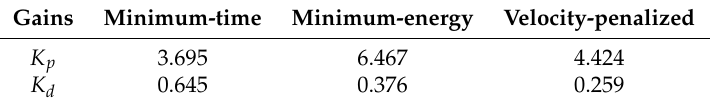
Table 2. The gains used during the simulation.